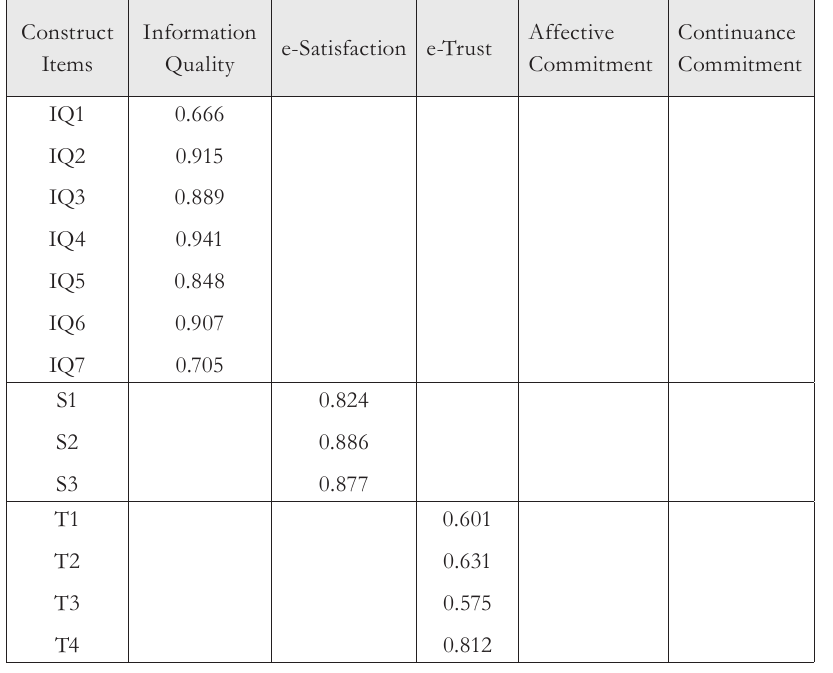
Tab. 2 - Results of exploratory factor analysis (EFA). Source: Authors